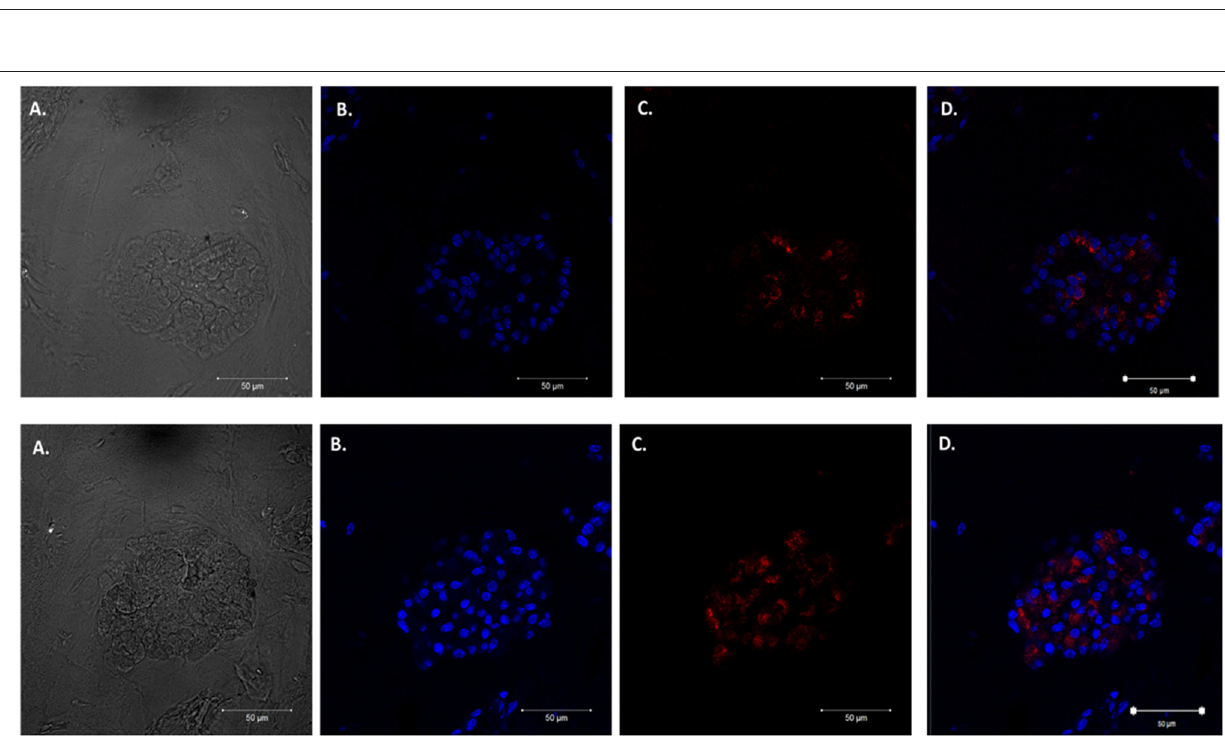
Frontiers in Fungal Biology | www.frontiersin.org